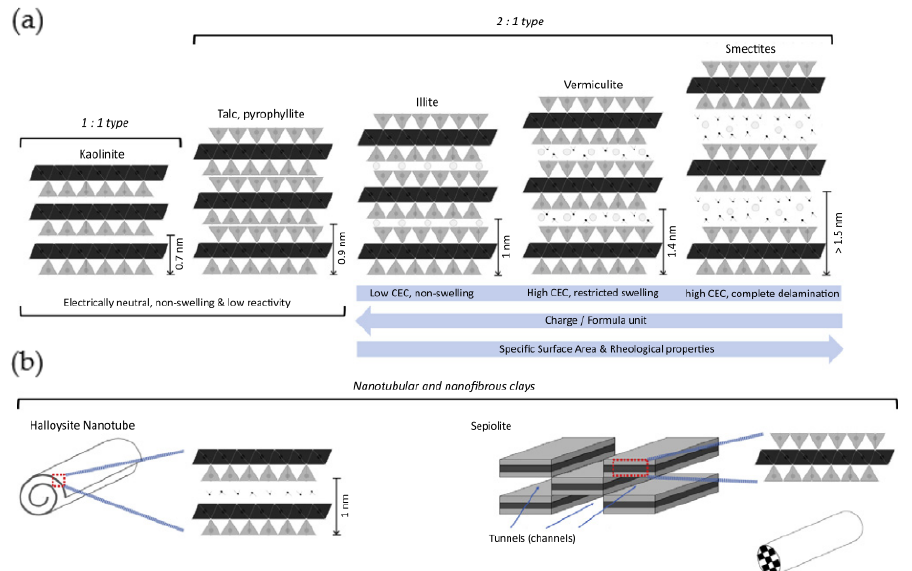
Figure 4. ( a ) The structure and reactivity of different groups of clay minerals. The reactivity of clays depends on their swelling capacity. Typically, these clay layers (aluminosilicate layers or 2:1 phyllosilicates) have an overall negative surface charge, due to isomorphic substitutions in the O (Al 3+ with Fe 2+ or Mg 2+ ) sheets and T (Si 4+ with Al 3+ ) sheets, which is balanced out by exchangeable metal cations such as Fe 2+ , Ca 2+ , Na + , Li + , and Mg 2+ , occupying the clay interlayer space, as well as water molecules. The capacity for hydration, swelling and dispersion increases with the negative charge value. Thus, between the negatively charged surfaces of the clay layers a positively charged layer is formed, shaping the whole crystal structure when stacked up. The aspect ratio of clay layers (length/thickness ratio) is very high (>1000), since each layer is around 1 nm thick and 300 Å to several microns wide in lateral dimensions. ( b ) Distinctive structue from other clay minerals: halloysites (from the 1:1 family) and sepiolites (from the 2:1 family). (Reprinted with permission from [29]. Copyright 2018,